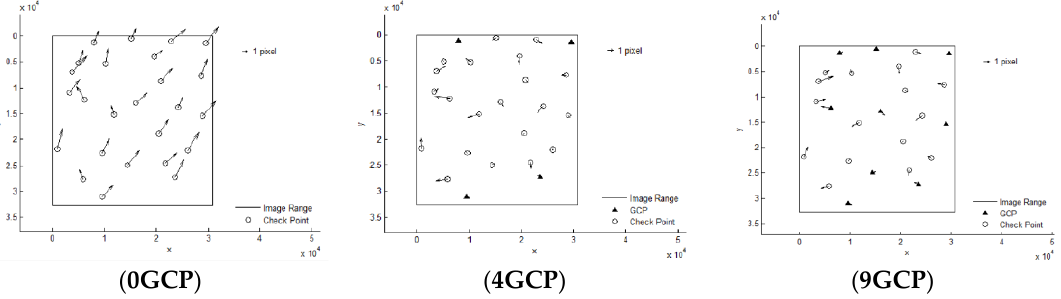
Figure 5. Residual distributions of check points of orientation for SPOT6.